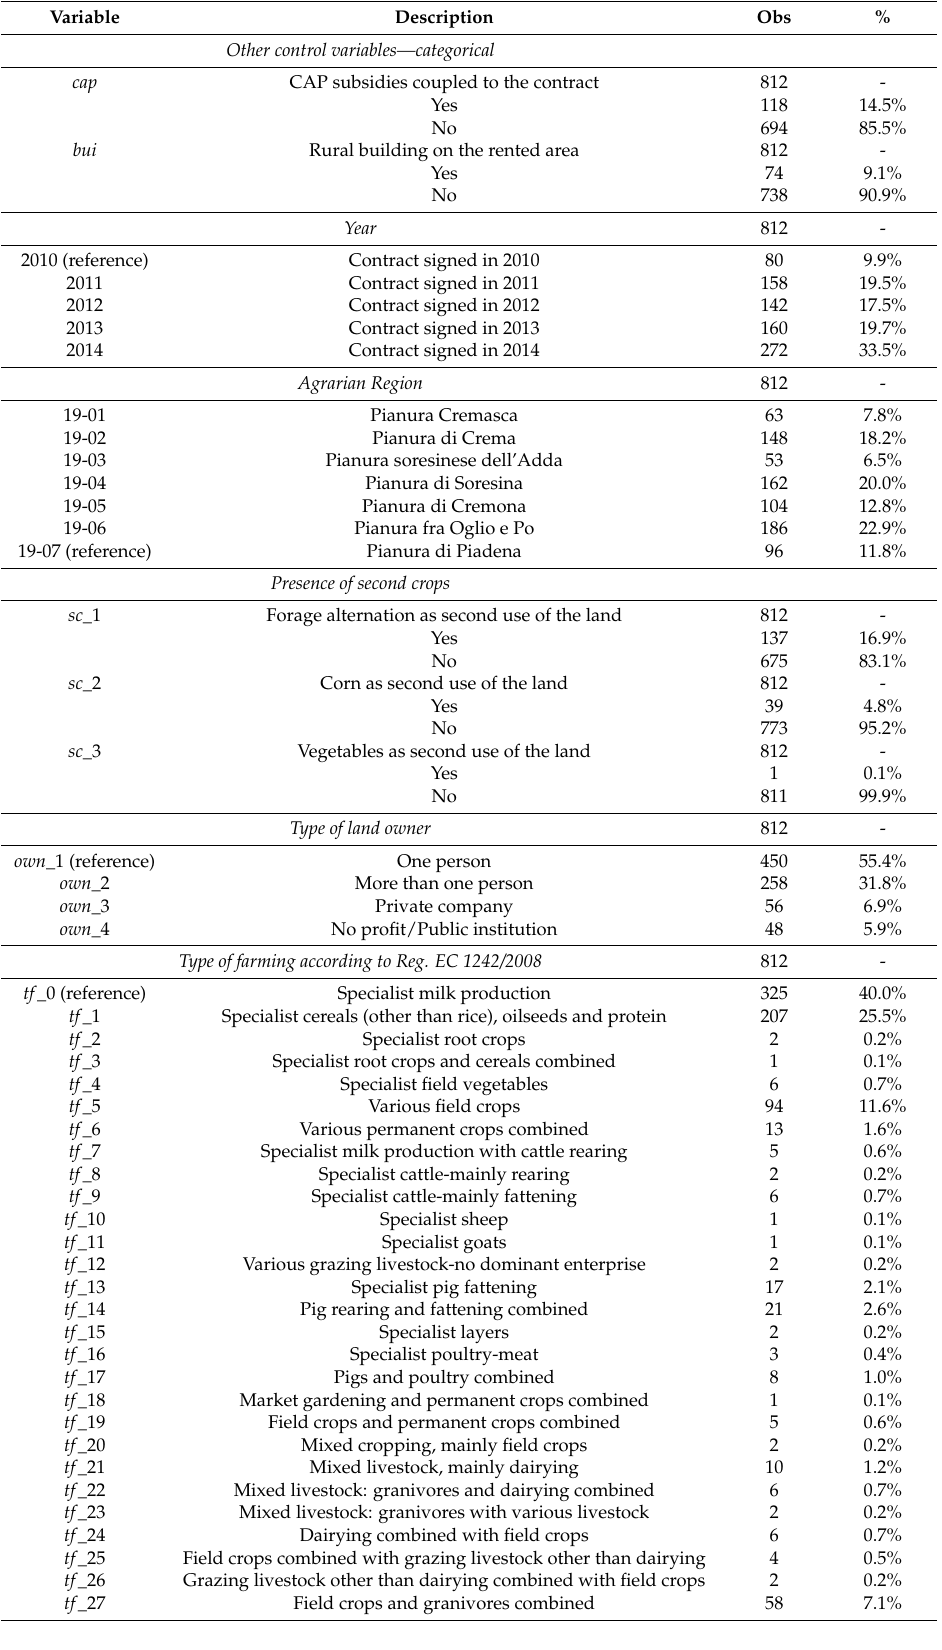
Table C2. Descriptive statistics of categorical variables in regression sample.